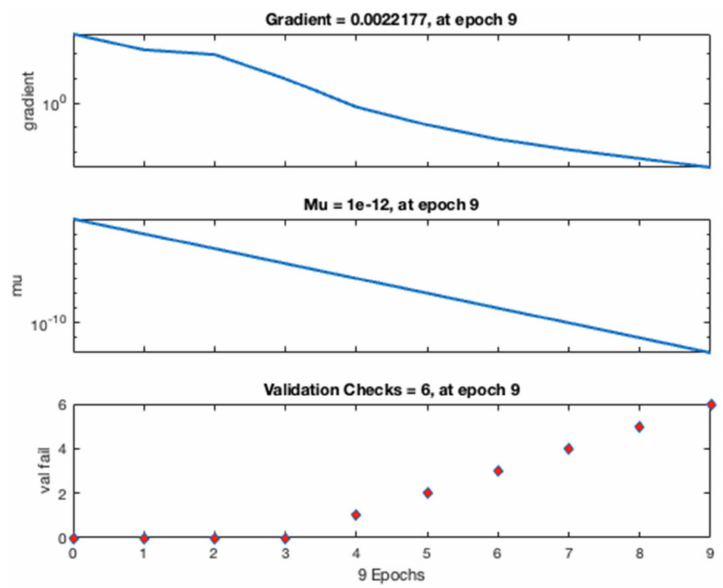
Figure 2. Performance of the training process of model one.